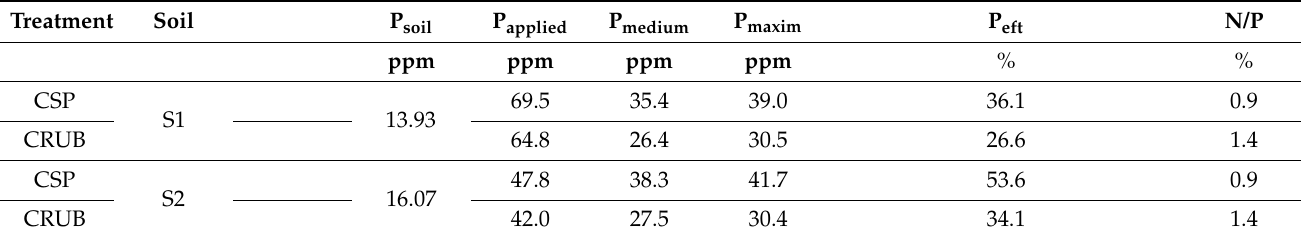
Table 5. P availability